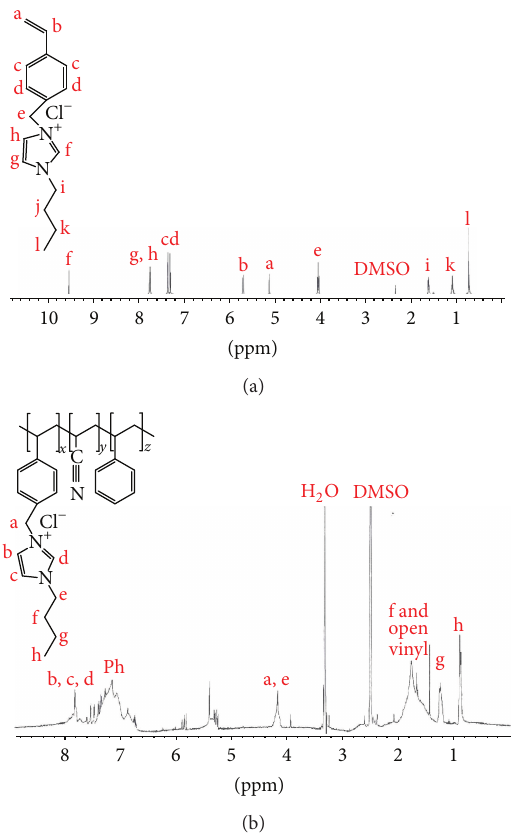
Figure 3: 1 H NMR spectra of the synthesized vinyl ILs (a)